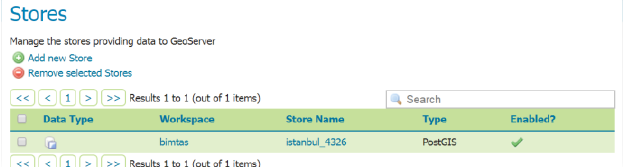
Figure 4. GeoServer publishing spatial data layers from the database through a PostGIS